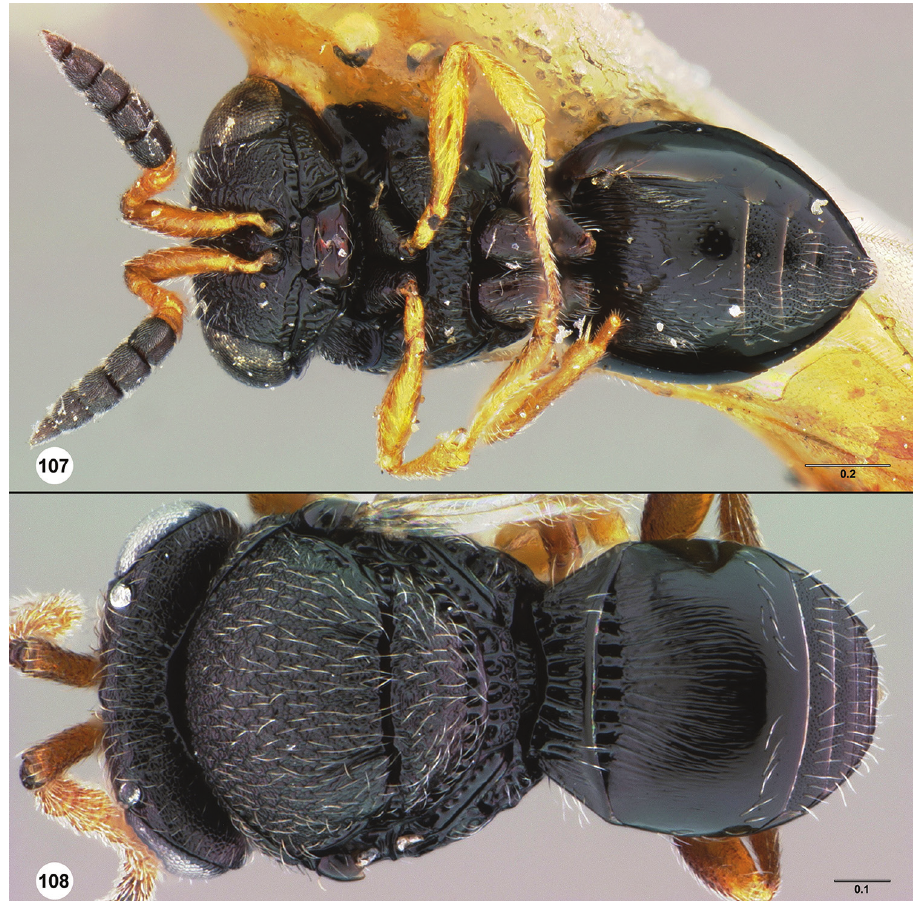
Figures 107–108. T. mitsukurii 107 female holotype (USNMENT00989031), head, mesosoma, meta- soma, ventral view 108 female (USNMENT00675722). Scale bars in millimeters. separate from postacetabular sulcus. Course of episternal foveae dorsally: